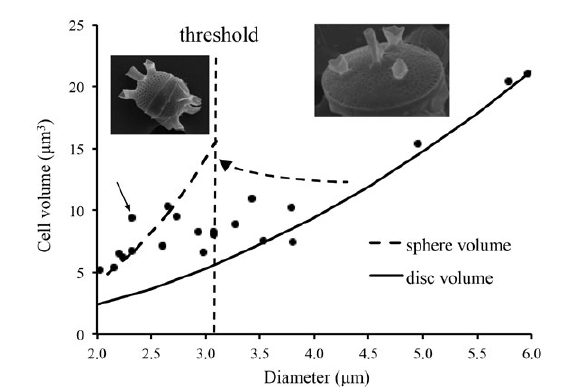
Fig. 6. – The relationship between diameter and cell volume in Minidiscus comicus . The lower curve shows the decline in cell vol- ume for discoid cells and the upper curve shows the cell volume of spherical cells that are found when the diameter diminishes below the threshold at which size restoration can be induced (3.1 μm). The ‘outlier’ cell below 2.5 μm (arrowed) was a cell that had increased its volume by becoming oblong rather than spherical (see